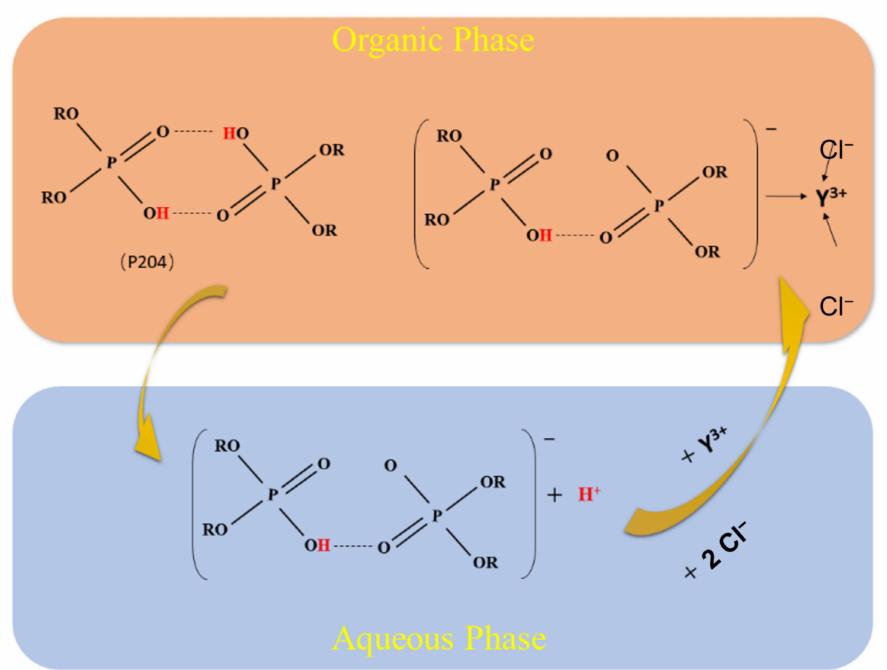
Figure 4. Schematic of the two-phase reaction during the solvent extraction.